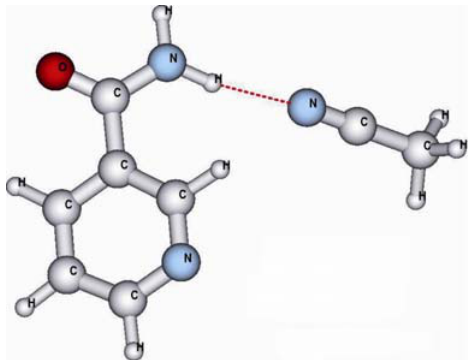
Figure 4. The hydrogen bond between MeCN and